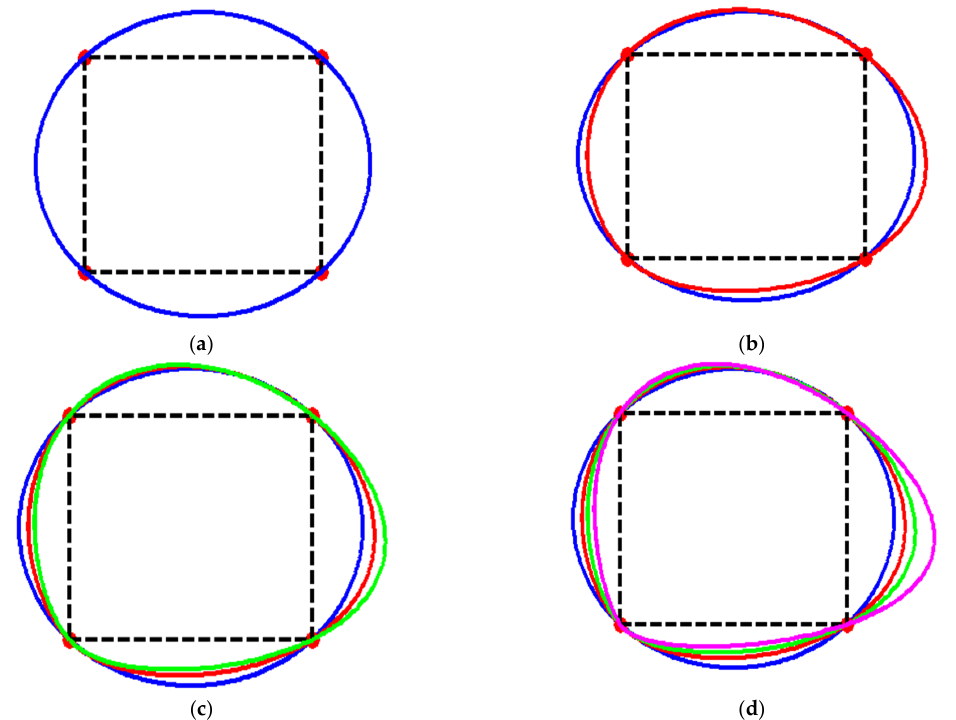
Figure 12. ( a – d ) are RQTS curve through biased tension, by ρ k = 2, 3, 5, and 10 for any k th interval.